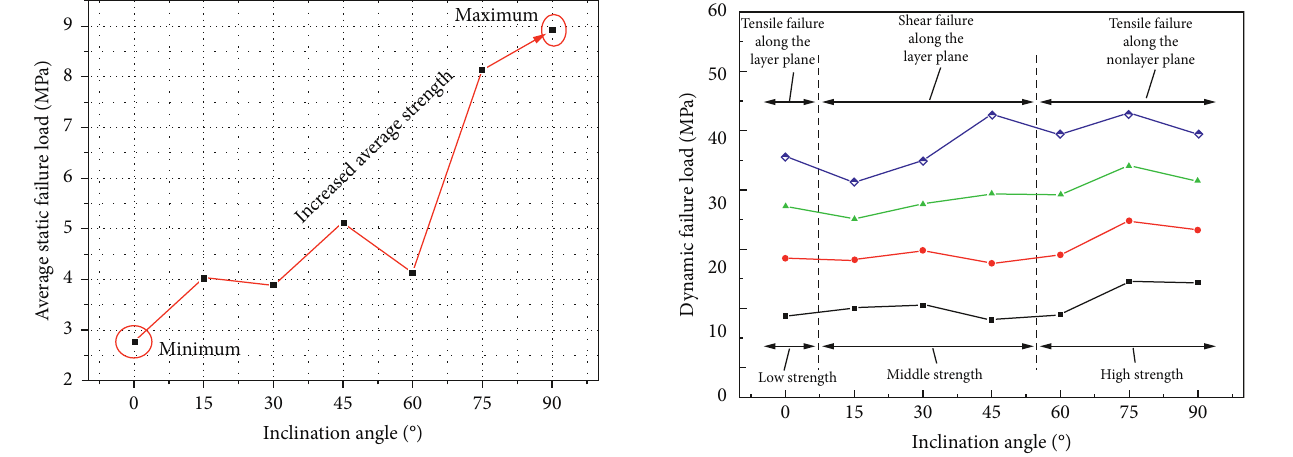
Figure 10: The relationship between the average failure load and the inclination angle.